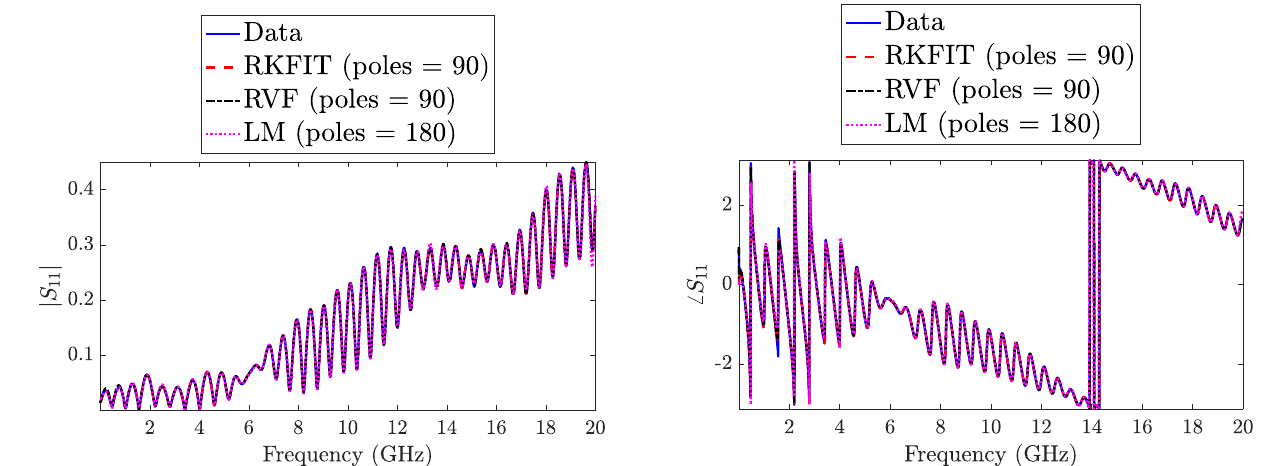
Figure 2. Comparison ofRKFIT with RVF and LM models with given data for S 11 of Section 3.1.